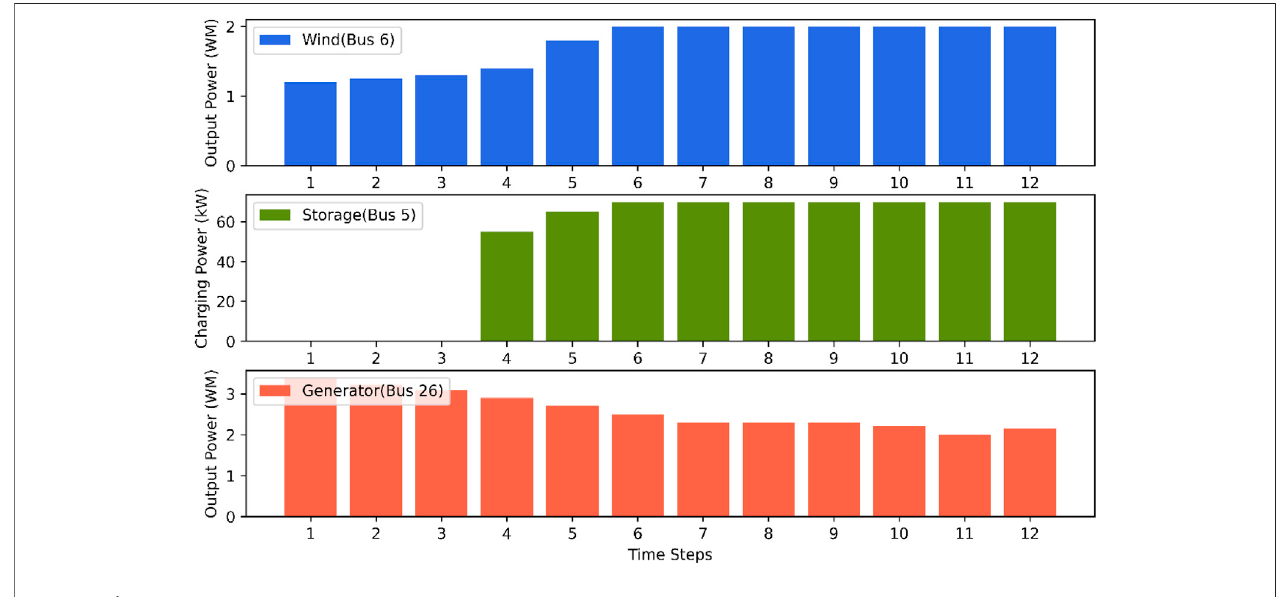
FIGURE 5 | Dispatch actions during high renewable power